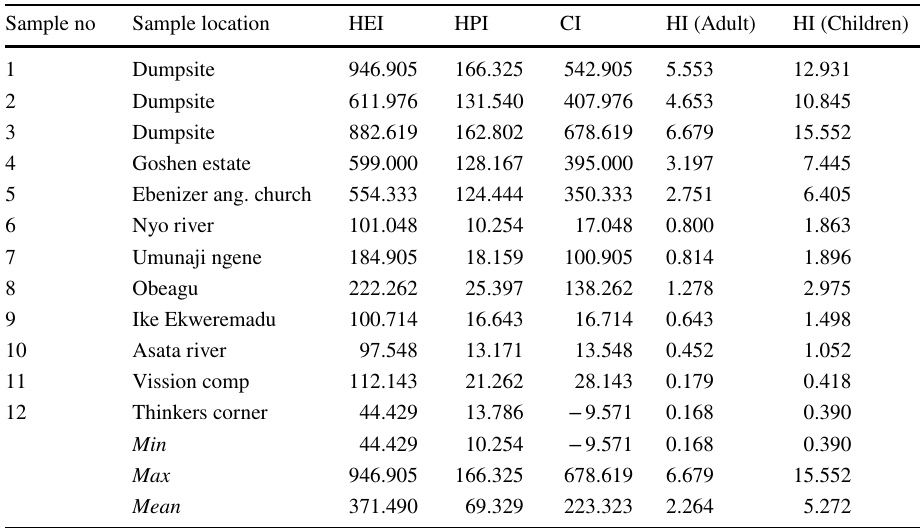
Table 8 Summary results of HI, HPI, HEI, and CI assessments